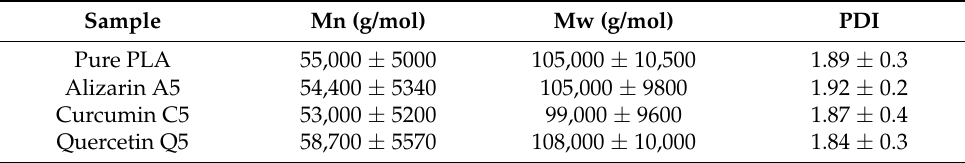
Table 3. Average molecular weights and PDI of PLA and its composites.